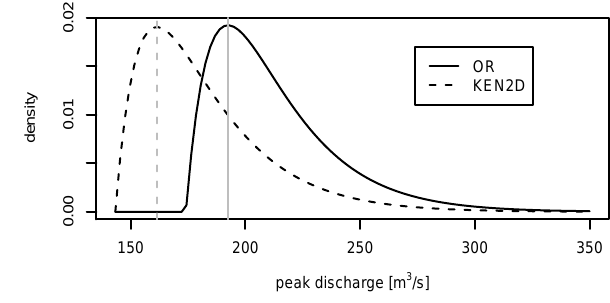
Fig. 8. PDF of Q p in the OR and KEN2D ensembles. The most likely design discharge values are indicated by vertical lines.